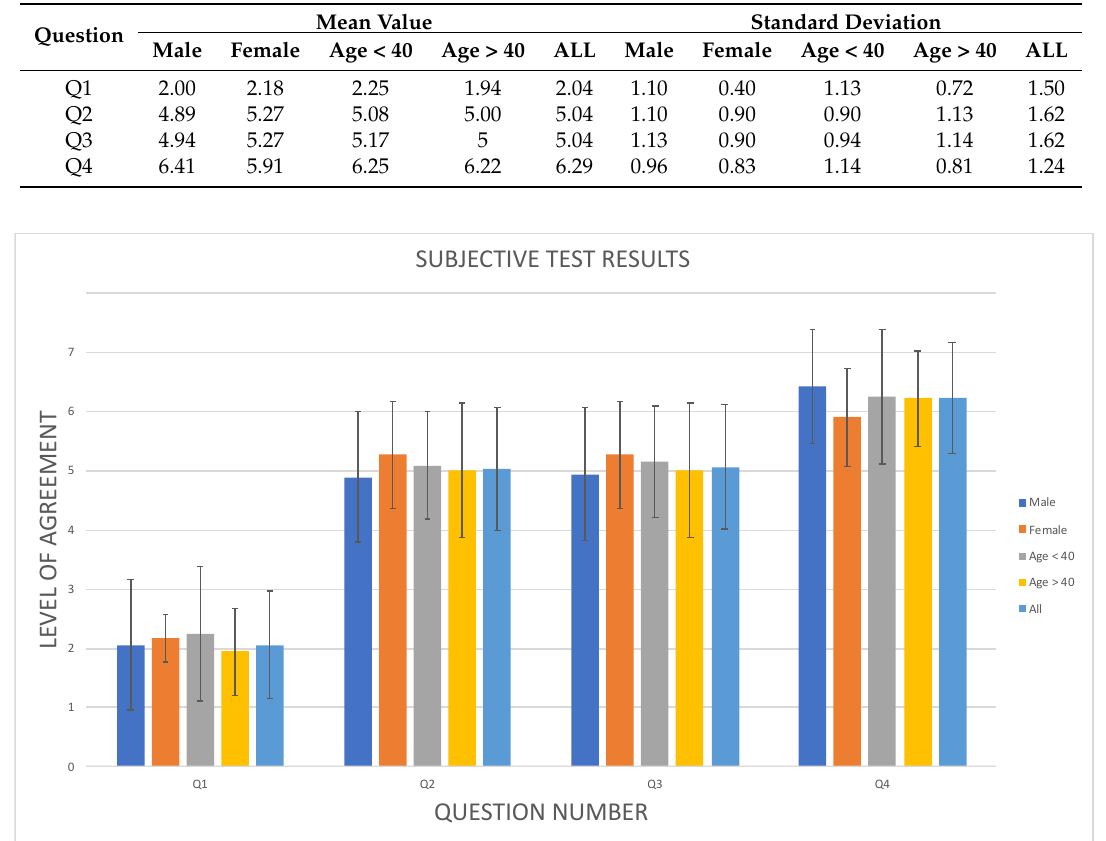
Table 3. Subjective test results. The mean value and the standard deviation of the level of agreement, ranging from 1 (strongly disagree) to 7 (strongly agree), has been computed for each question and for each category.